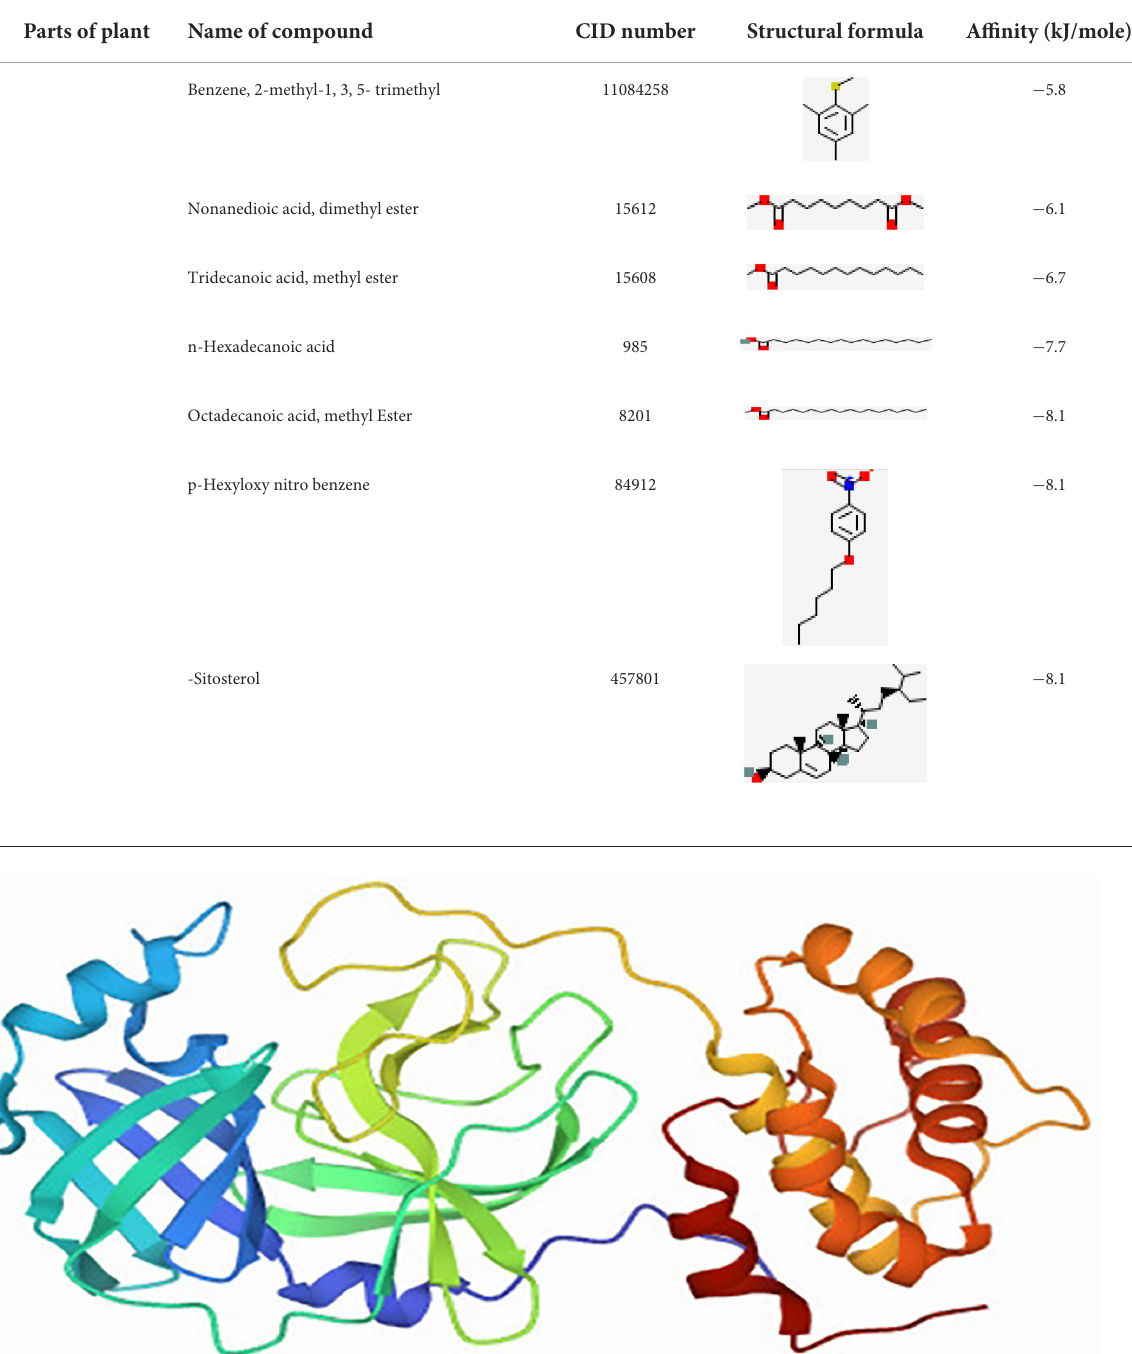
Arisaema genus (59). The Japanese encephalitis (JE) condition was caused by the Japanese encephalitis virus (JEV) and affects millions worldwide. The genus Arisaema was used to cure